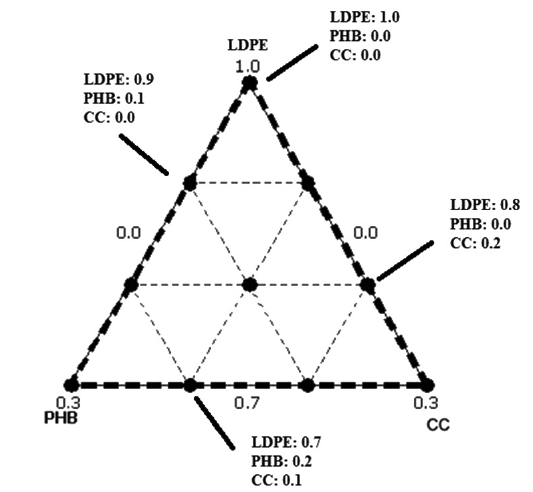
Figure 1. Simplex-lattice design region.